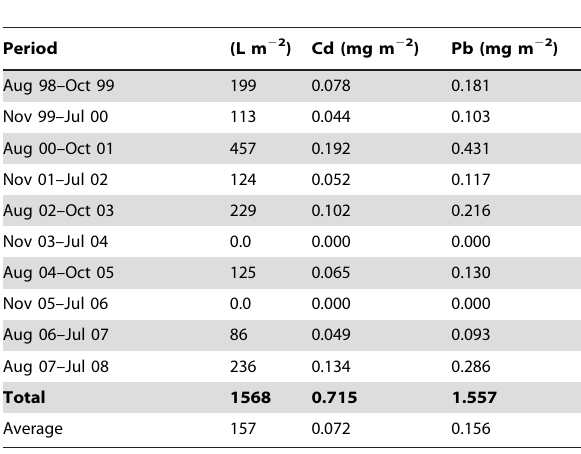
Table 5. Leaching of water (L m 2 2 ), Cd (mg m 2 2 ) and Pb (mg m 2 2 ) for the ten simulation events in the control